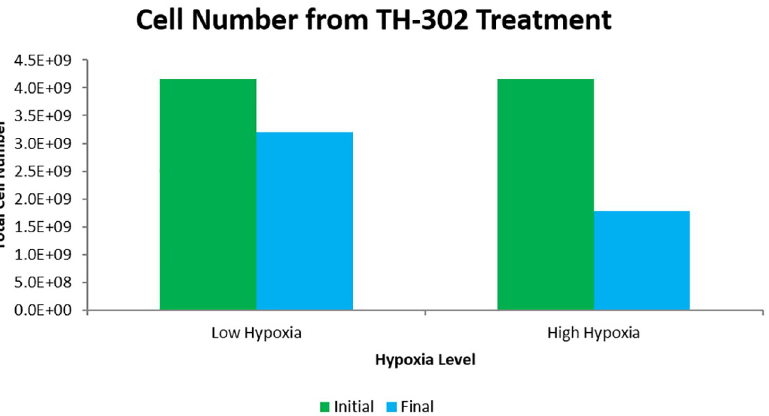
Fig 4. Comparison of TH-302 effectiveness for tumours of different hypoxic levels. The tumour is allowed to grow for 15 days before TH-302 treatment. TH-302 is given every other day starting on the 15th day and the plasma concentration is assumed to have a half life of 3 hours. The high hypoxic case is from the parameters listed in Table 1 while the low hypoxia case assumes a halved oxygen supply rate ( r ). Initial cell number is taken from the time step k immediately before treatment and final cell number is taken from the time step immediately following treatment. TH- 302 treatment kills only 23% of tumour cells in the low hypoxic case while it kills 57% of cells in the high hypoxic case.